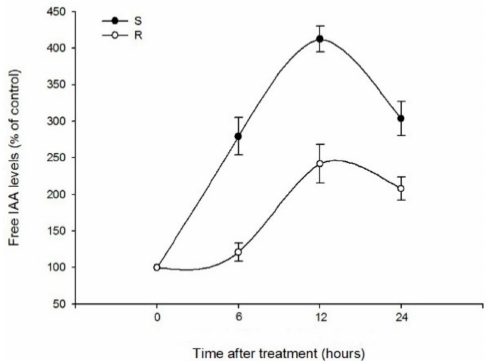
Figure 3. IAA contents in root tips were measured in S (JNNX-S) and R biotypes (SSXB- R) after treatment with quinclorac (50 µ M) at 0 h, 6 h, 12 h and 24 h. Data are the mean values of at least three biological replicates. The standard errors of the means are described by vertical bars.